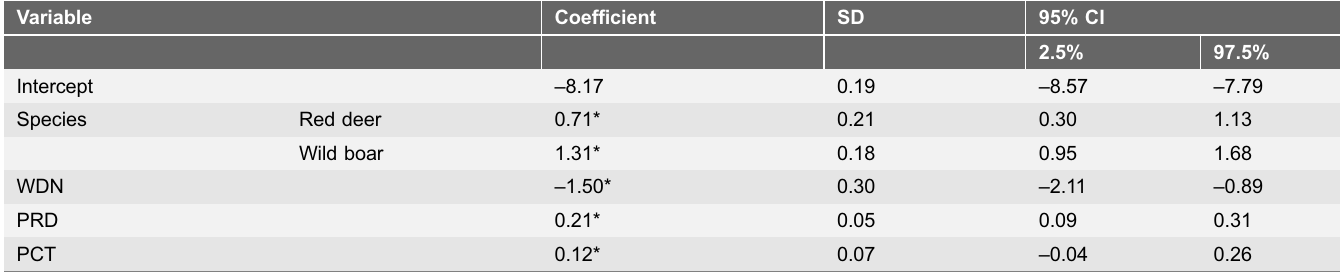
Explanatory categorical variable was the TB-tested species: fallow deer, red deer and wild boar. Quantitative variables were water point density (WDN) and predicted species abundance (PRD in red deer and PCT in cattle) obtained from the models summarised in Table 2 and Fig. 2. Coefficients, standard deviations (SD) and 95% credible intervals (CI) are shown. Coefficients of species categories are relative to the fallow deer. Significant variables are marked with